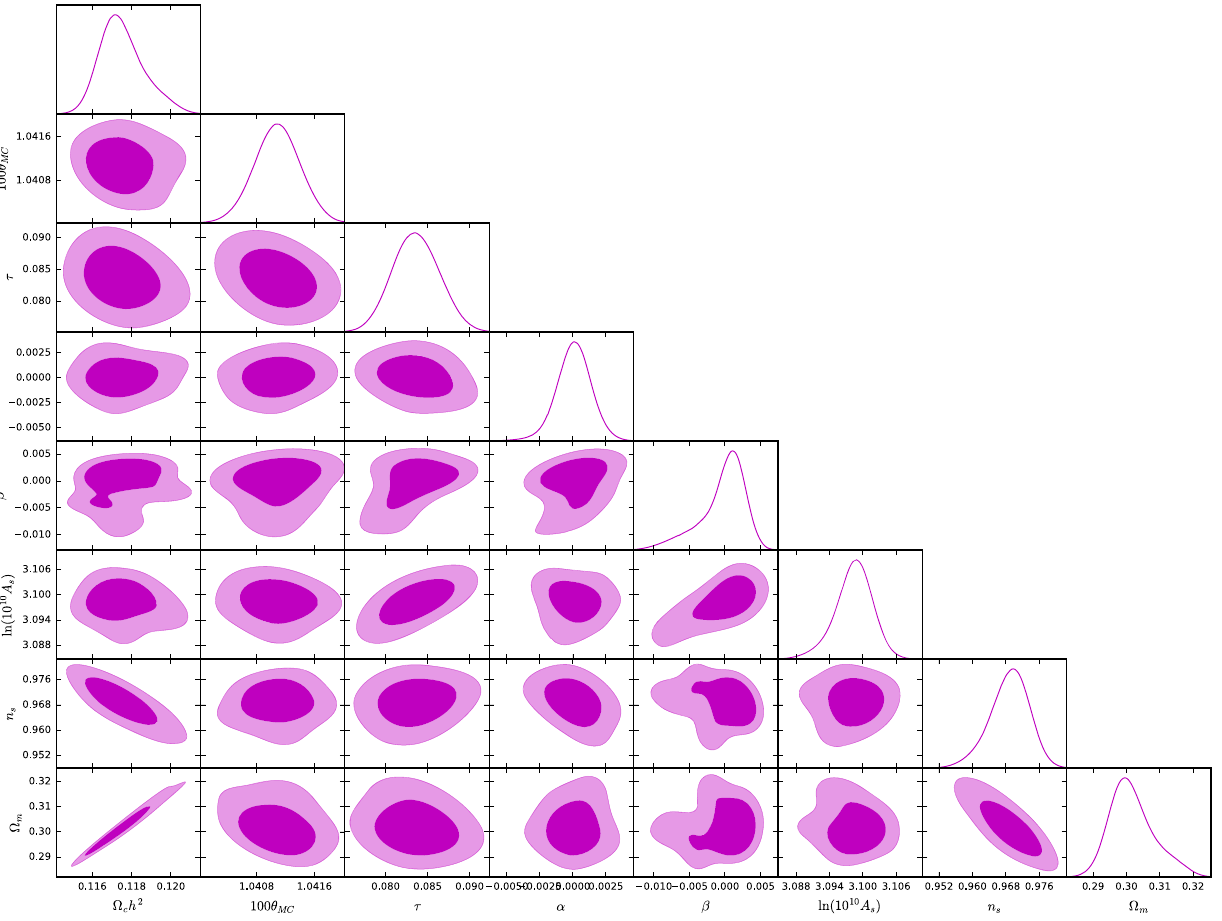
Fig. 2 The 1-dimensional marginalized distributions and 2-dimensional contours for the parameters of the F (cid:5) model by using the data combination